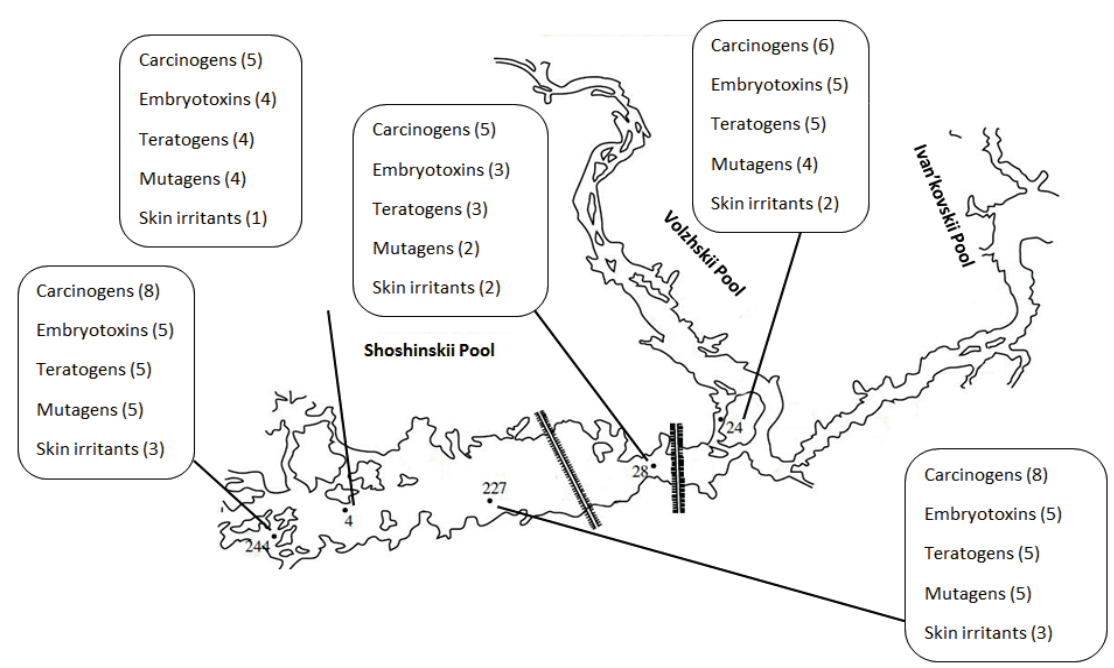
Fig. 4 Toxic hazard of some PAHs, founded in bottom sediments of Ivankovo Reservoir (on stations of sampling).